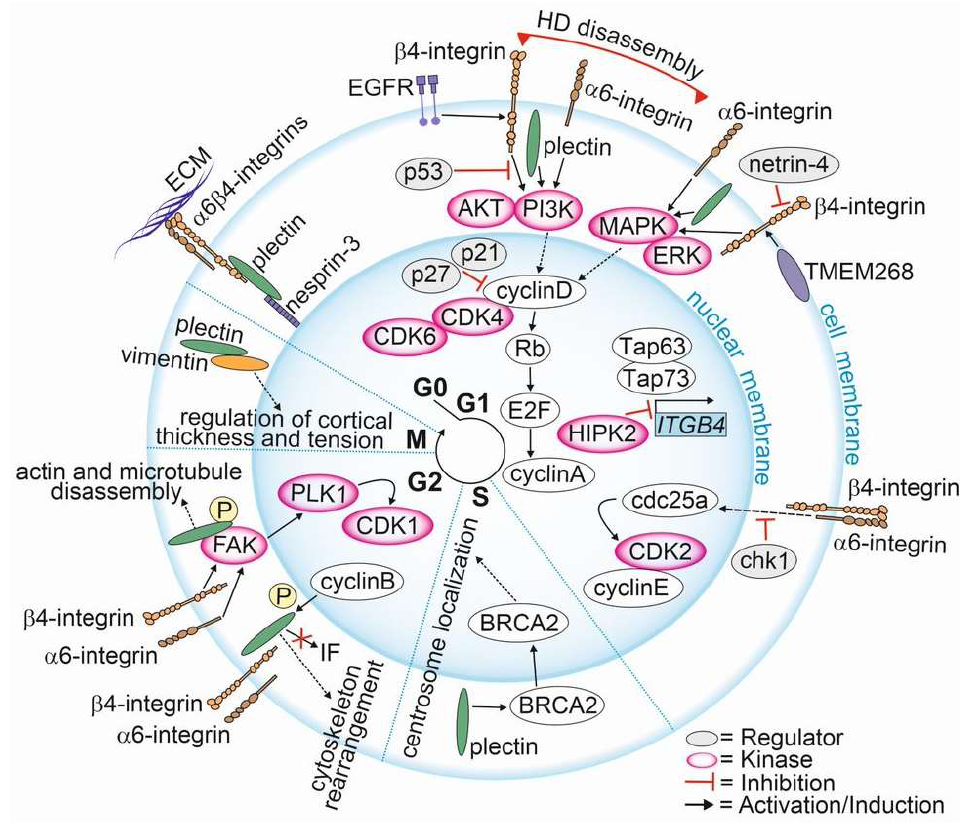
Figure 3. Involvement of hemidesmosomal proteins in cell cycle regulation.